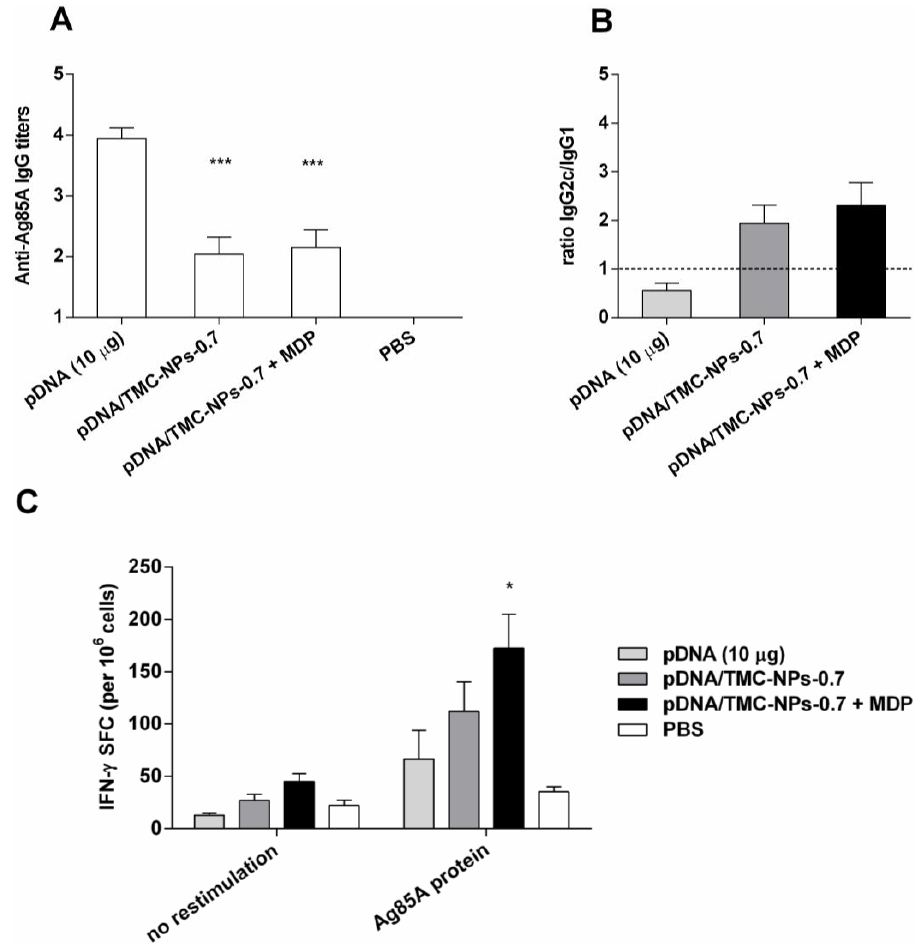
Figure 4. Immune responses in mice one week after the second booster injection (intramuscularly).